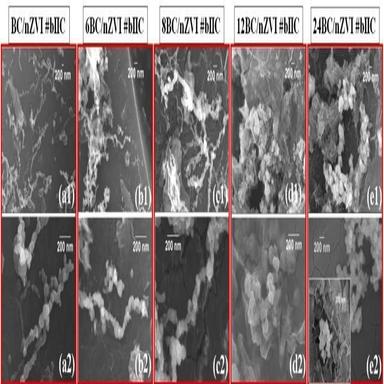
SEM images of: (a1 and a2) BC/nZVI, (b1 and b2) 6HBC/nZVI, (c1 and c2) 8HBC/nZVI, (d1 and d2) 12HBC/nZVI, and (e1 and e2) 24HBC/nZVI, all synthesized under the optimized conditions.